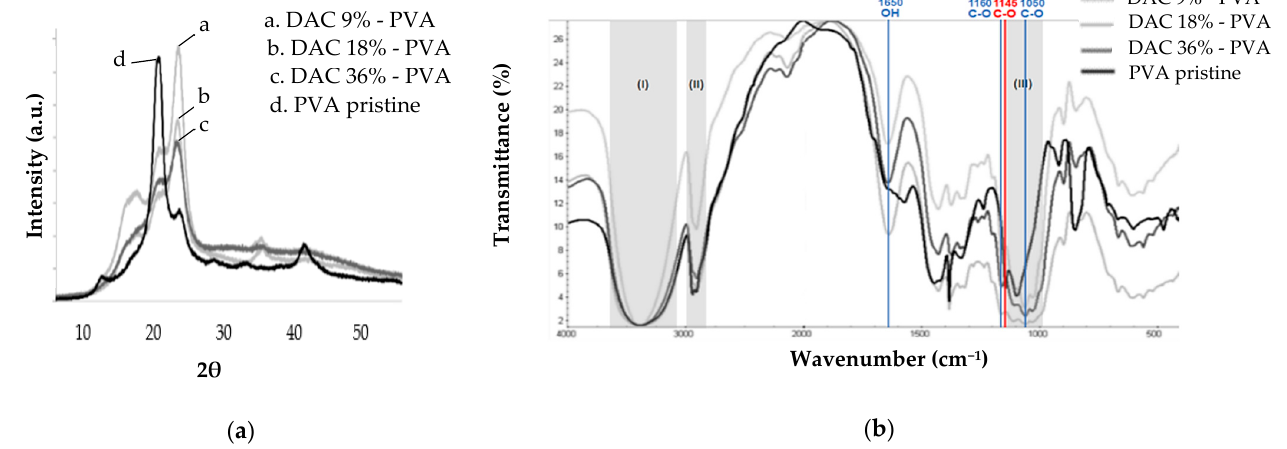
Figure 4. PVA and DAC-based composite scaffolds ( a ) XRD diffractograms; ( b ) FT-IR spectra.